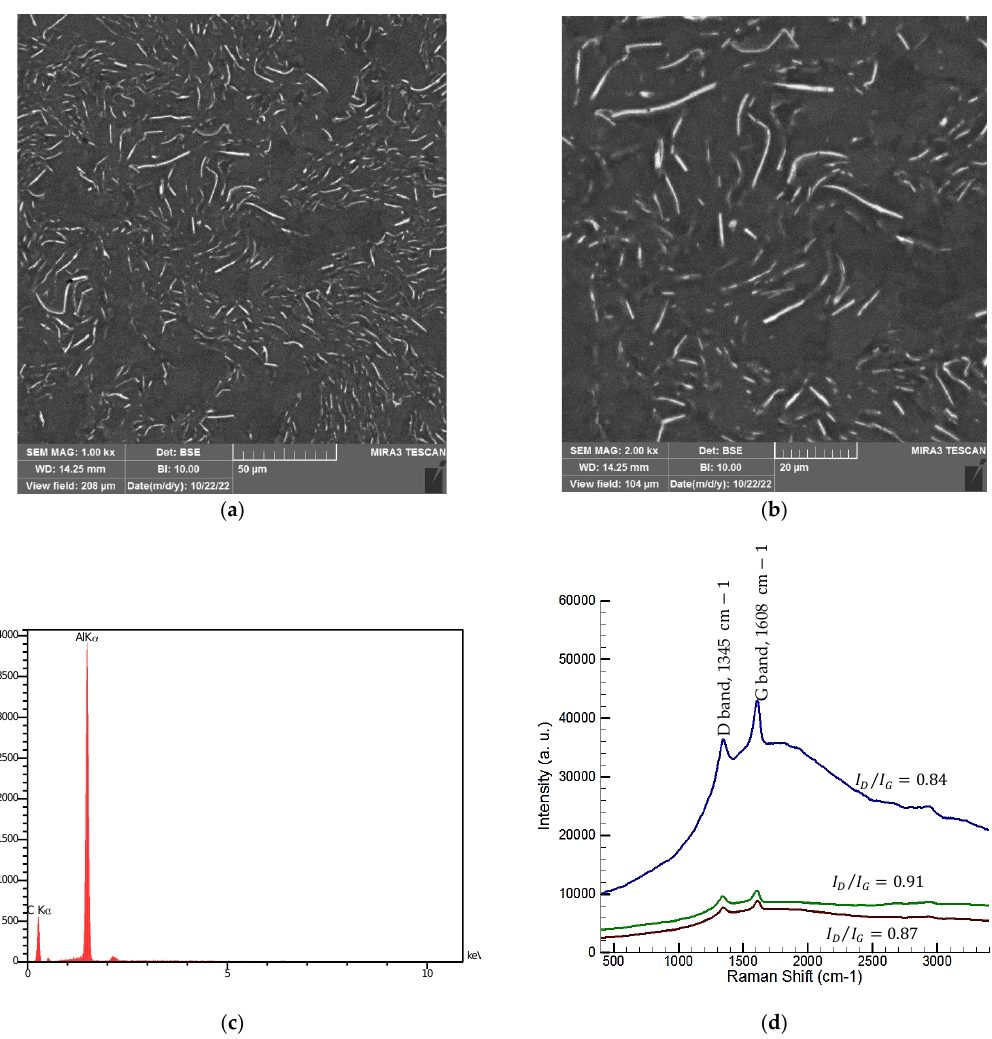
Figure 6. FESEM images of the Al-GNP nanocomposite at a ( a ) low magnification and ( b ) high magnification; ( c ) EDX and ( d ) Raman analysis.